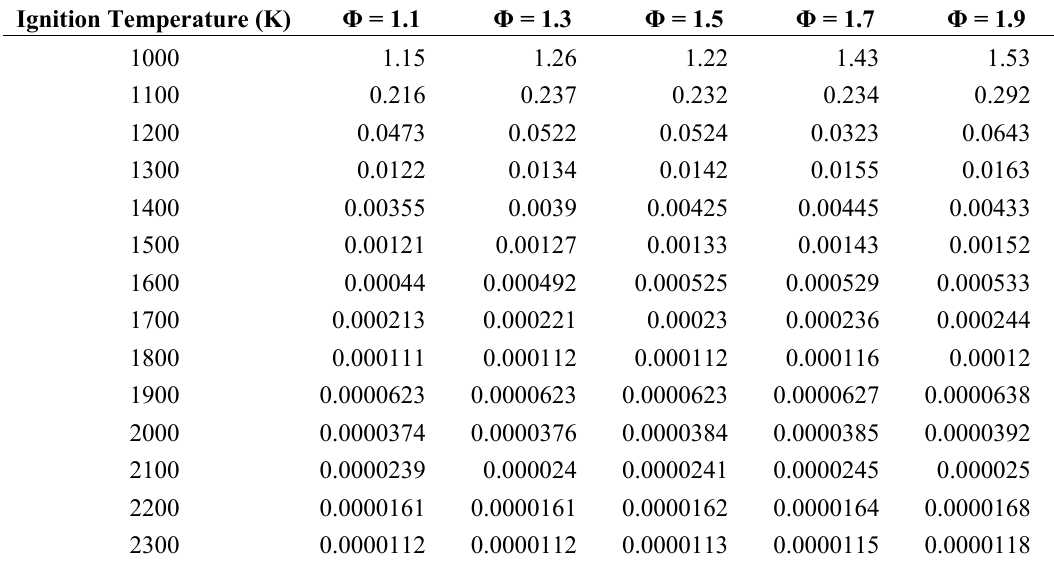
Table 4. Ignition Delay, s, 1.1 ≤ Φ ≤